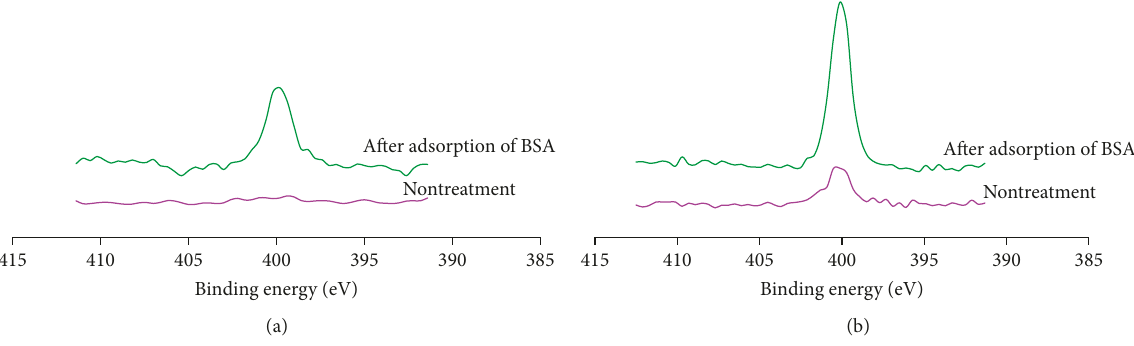
Figure 7: N1s XPS spectra of (a) Ti and (b) TNS QCM sensors after immersion in BSA.